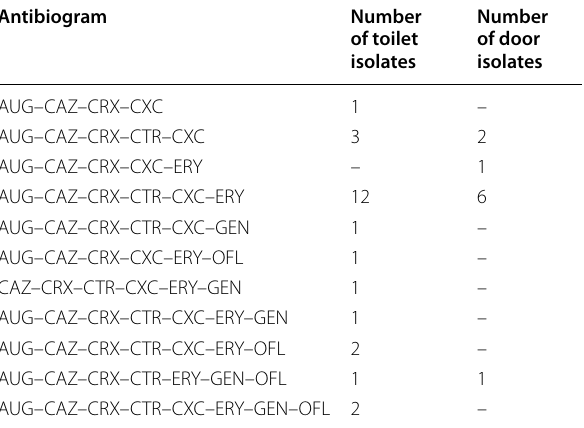
Augmentin (AUG), Ceftazidime (CAZ), Ceftriaxone (CTR), Cefuroxime (CRX), Cloxacillin (CXC), Erythromycin (ERY), Gentamicin (GEN), Ofloxacin (OFL)